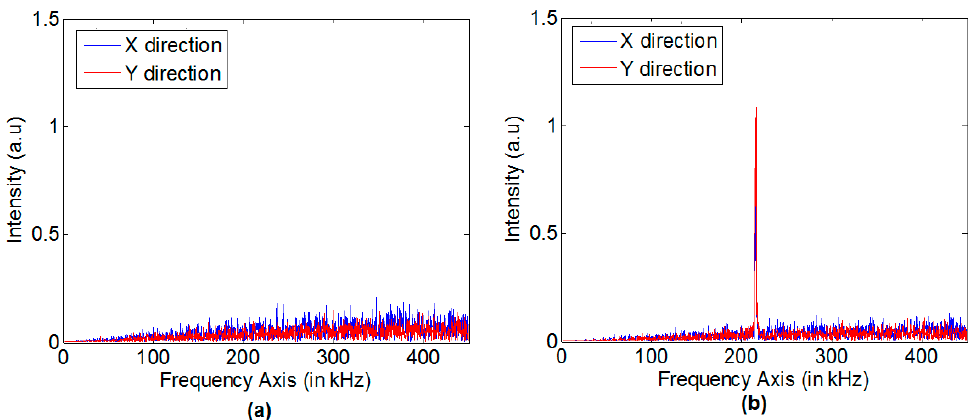
Figure 3. Experimental Results: The oscillation frequencies of the speckle pattern in horizontal (X direction) and vertical (Y direction) axes; ( a ) without pumps and ( b ) with two pump waves.